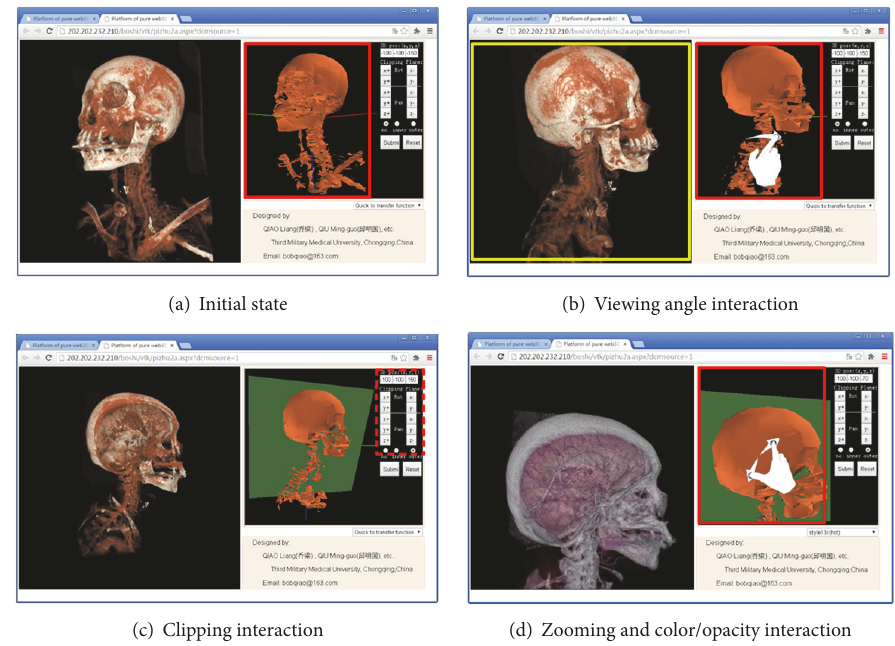
Figure 6: Screenshot and operational